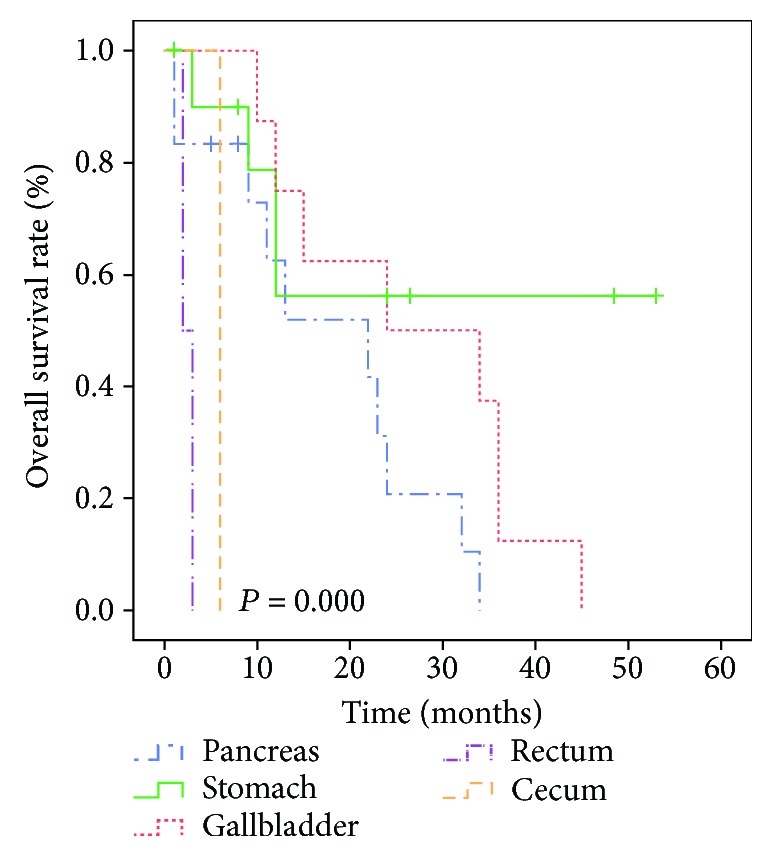
Prognostic values of the primary site of gastroenteropancreatic neuroendocrine carcinomas with liver metastasis. The survival curve shows that the total survival rate of patients with the gallbladder as the primary tumor site is higher than that of the stomach and pancreas, apart from the rectum and cecum (p < 0.05).